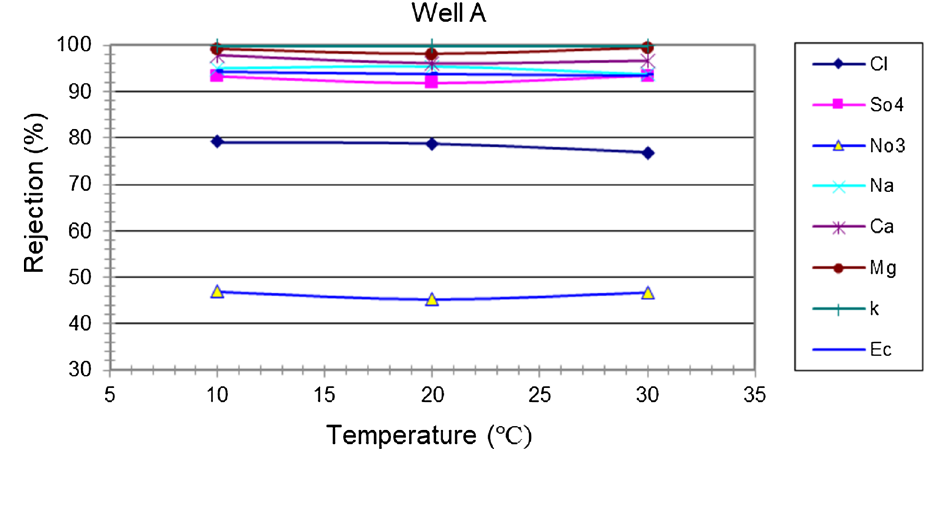
Fig. 6 Rejection rate of ions versus temperature (pressure: 8